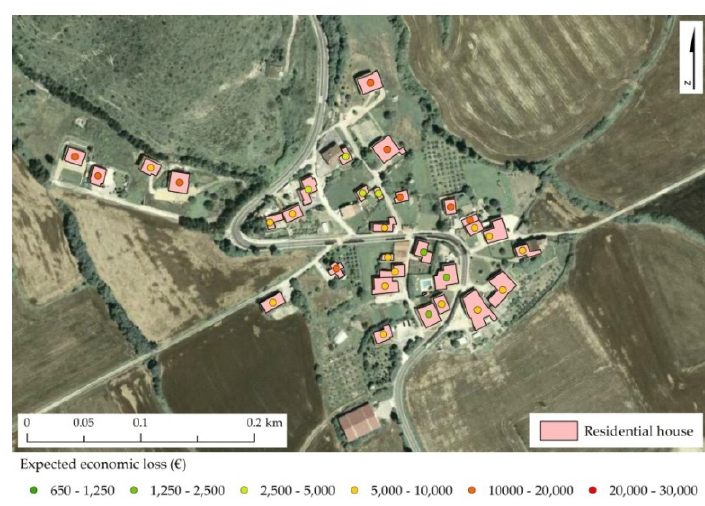
Figure 13. Close-up view of a residential house level wildfire risk map (eEL) for Marcalain (council cadaster polygon No. 8) expanded from Figure 12, over the June-2015 aerial photograph (idena.navarra.es). Other structures such as farm stores, churches and water deposits were excluded from the analysis. Overall, structures located in the periphery were more exposed to wildfires and presented higher potential losses. On the north side of rural communities, closer to shrublands and forest areas, higher wildfire hazard can enhance potential losses.